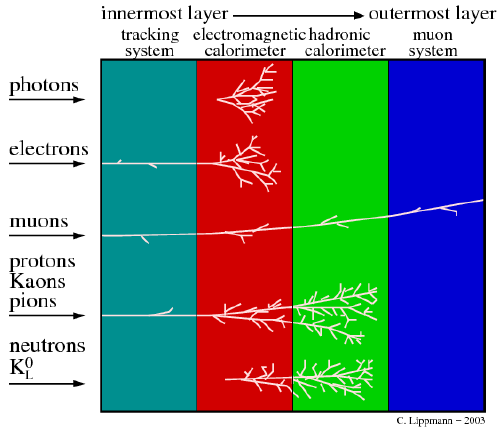
Figure 1. Particles draw patterns as they cross the detectors